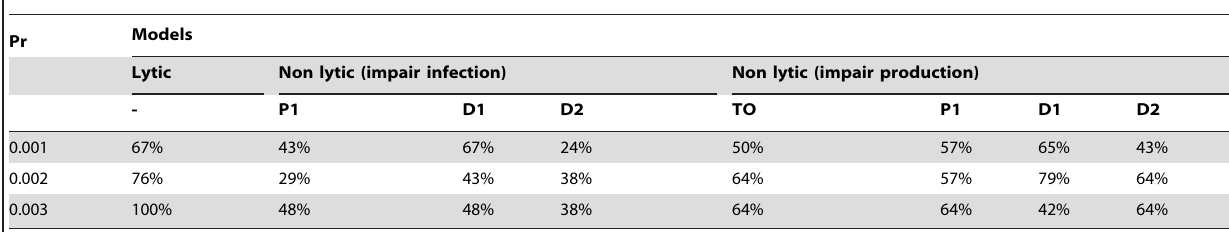
Abbreviations: Pr=Probability of recognition by CD8 + T cells, TO=Target Only, P1=Polarised secretion (r=1), D1=Diffusive secretion (r=1) and D2=Diffusive secretion